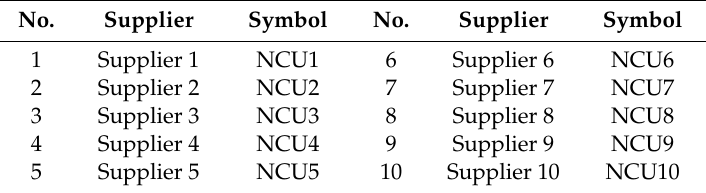
Table 6. List of material